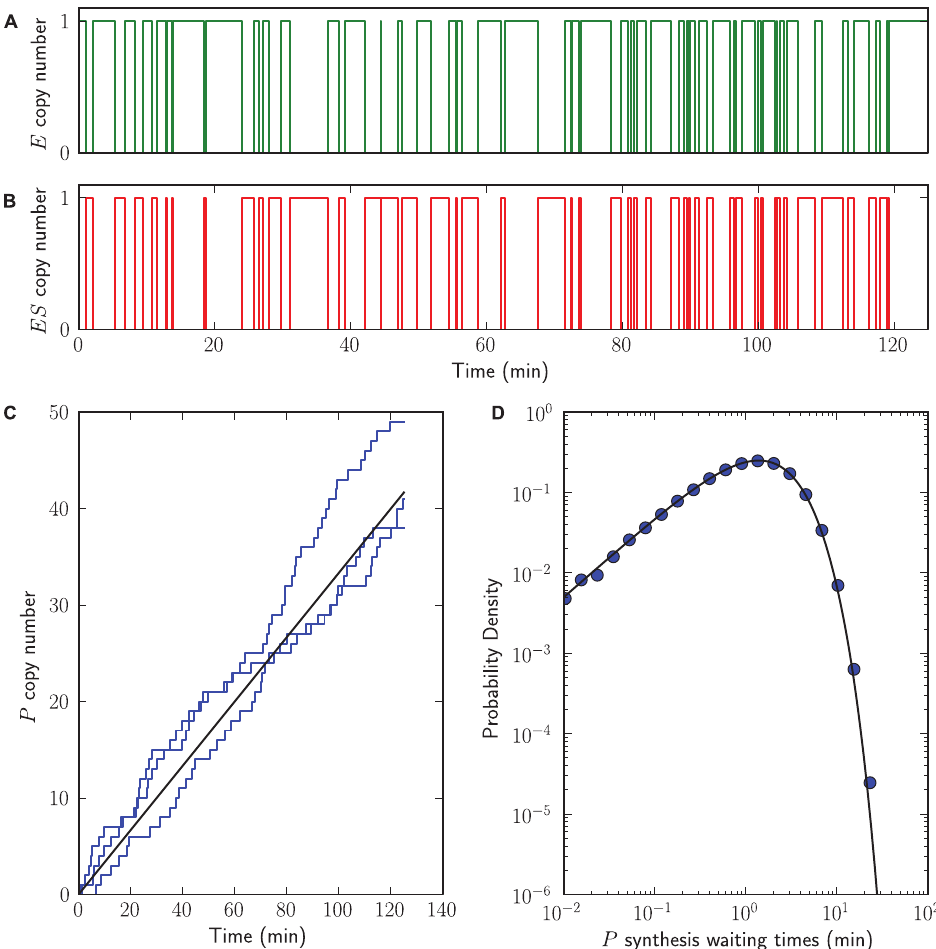
Figure 6. Single-molecule enzymology. StochPy plots for single-molecule enzyme activity simulations with StochPy simulations (step, markers, blue) and analytical solutions (solid, black) (A–B) time-series data of E and ES , E ( t ) z ES ( t ) ~ 1 . (C) three time trajectories that fluctuate around the analytical solution. This analytical solution corresponds to the mean rate of formation, which for stochastic simulations can be obtained by taking the average of many generated time trajectories. (D) event waiting times of product P formation peak.